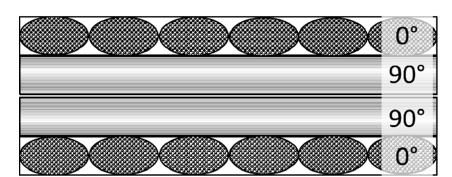
Figure 1. Schematic of the stack of each GFRP layer.